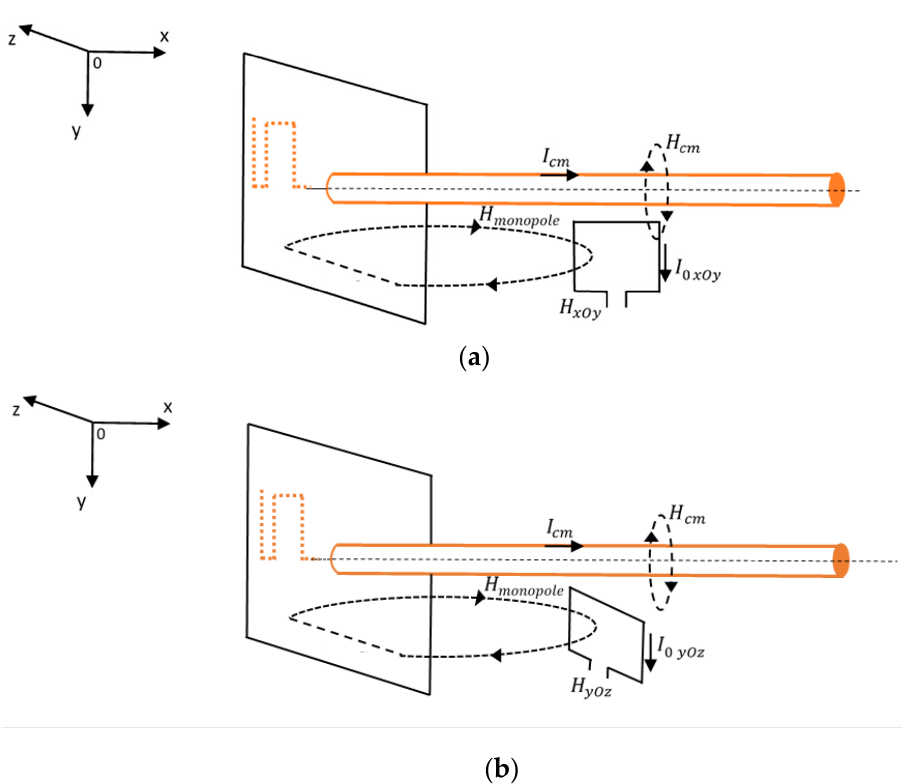
Figure 20. Magnetic field components through the PA: ( a ) xOy setup; ( b ) yOz setup. From (7) and (8), the field radiated by common mode currents can be extracted as :